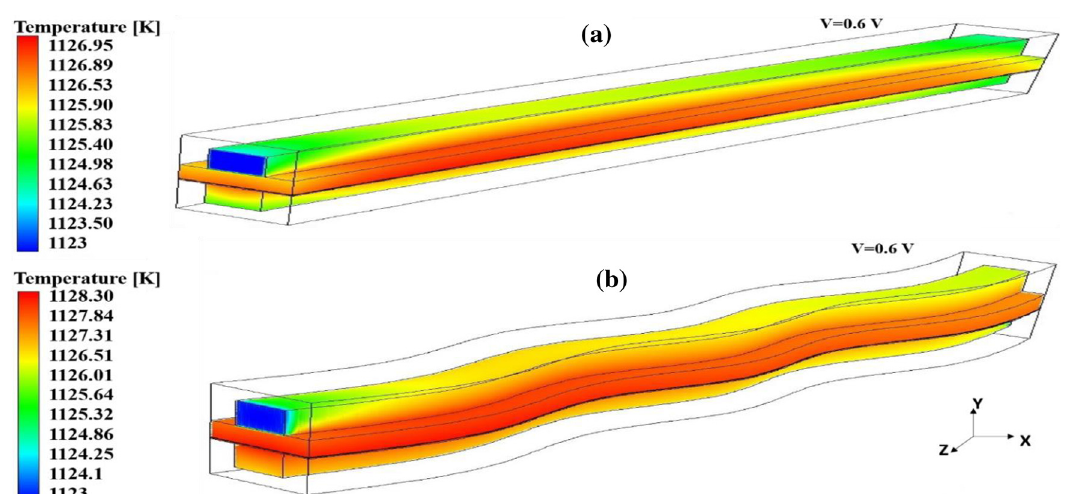
Fig. 6. Temperature distribution contour along the SOFCs cells for two different fl ow designs at 0.6 V.